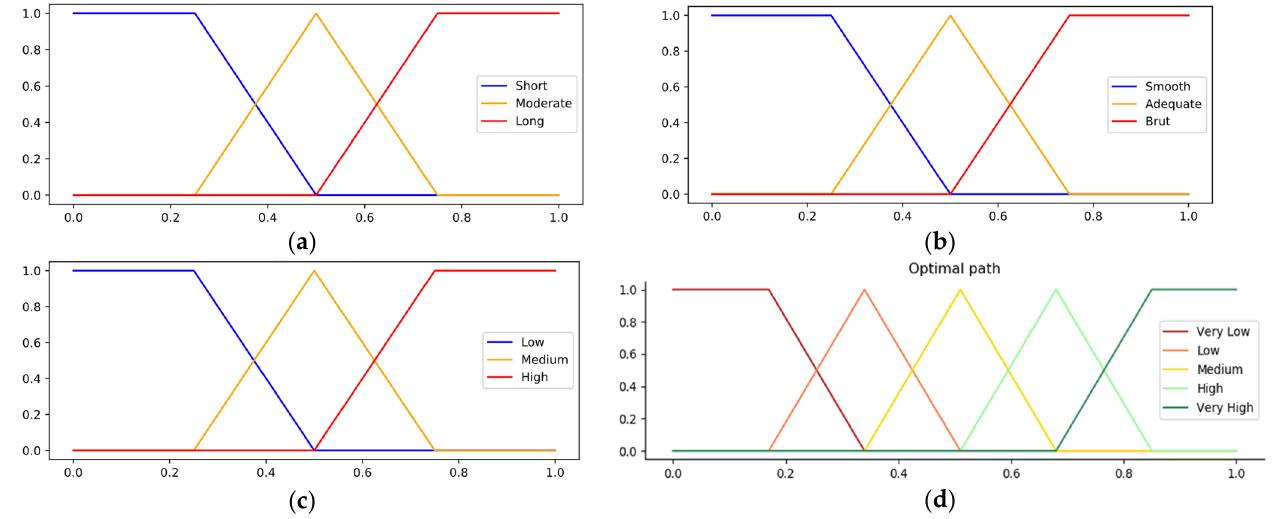
Figure 3. Membership functions of ( a ) path distance; ( b ) path turns; ( c ) fuel consumption; and ( d ) path optimality.